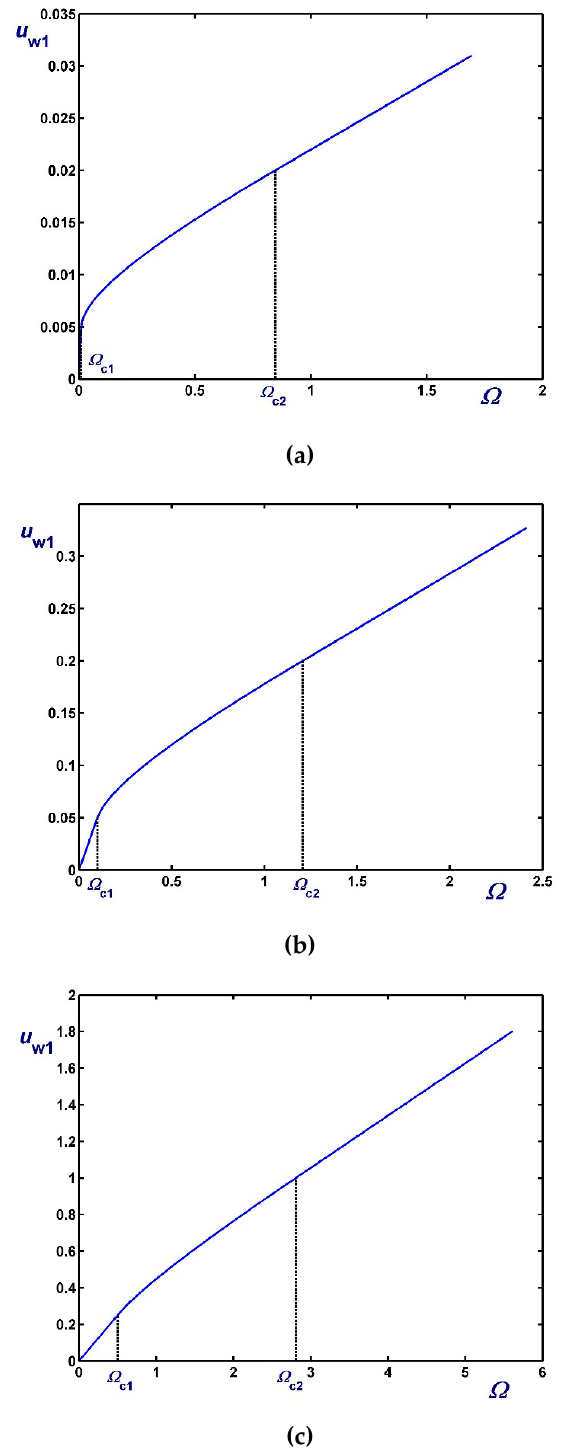
κ= 0 B = (no slip along the fixed outer cylinder), Figure 4. Inner wall slip velocity for κ = 0.5, B 2 = 0 (no slip along the fixed outer cylinder), and Figure 4. Inner wall slip velocity for 0.5 , 2 Navier slip along the rotating inner cylinder: ( a ) B 1 = 0.01 (weak slip); ( b ) B 1 = 0.1 (moderate slip); 0.01 B = (weak slip); ( b ) 0.1 B = and Navier slip along the rotating inner cylinder: ( a ) 1 1 ( c ) B 1 = 0.5 (strong 0.5 B = (strong slip). (moderate slip); ( c ) 1